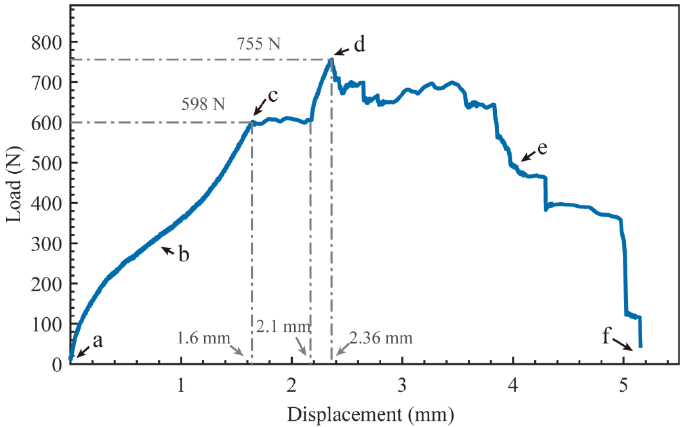
Figure 10. Load-displacement curves of metallurgical bonded AFS at the panel peeling test. Materials 2022 , 15 , 6931